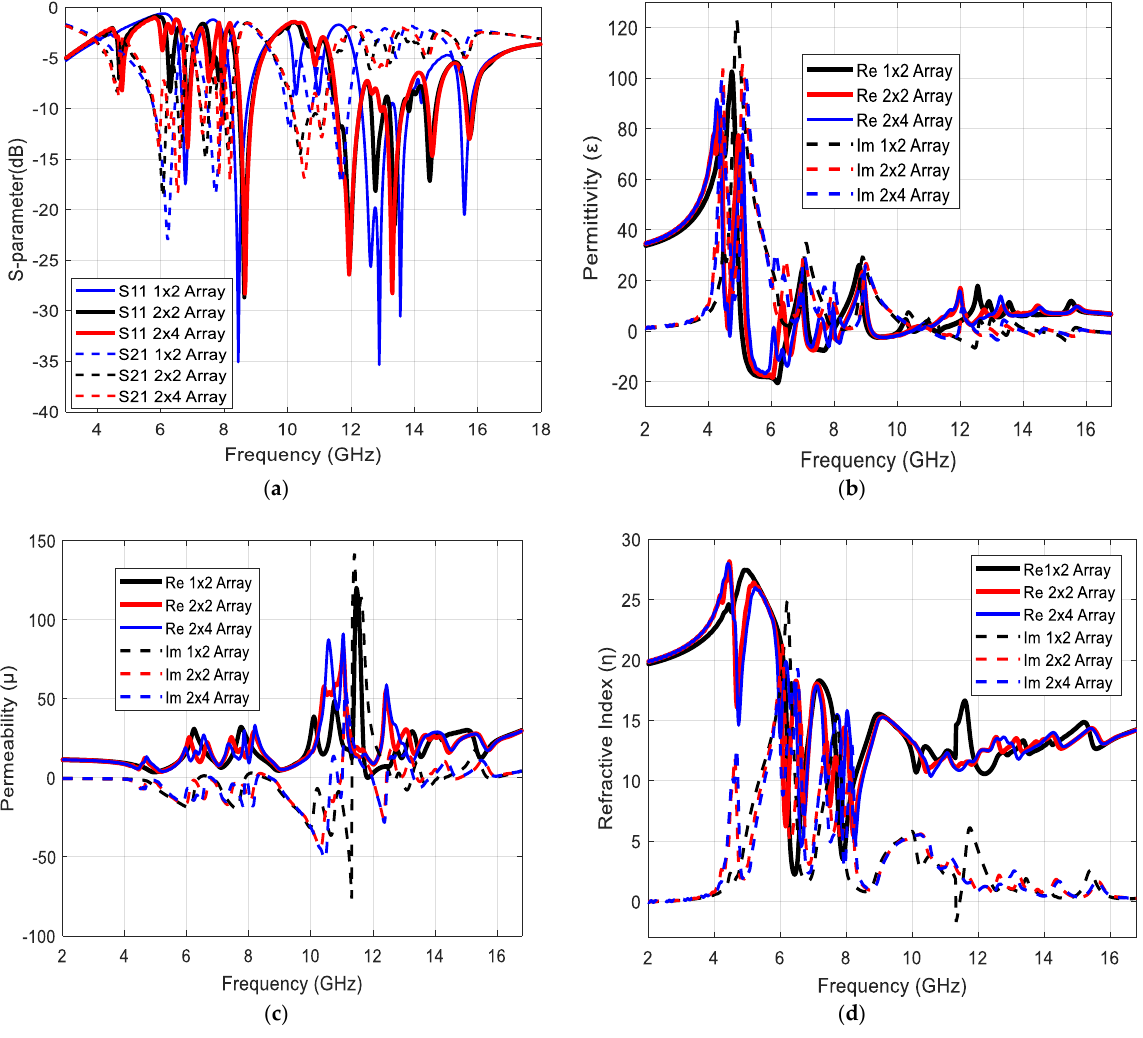
Figure 8. Parameters of array configurations: ( a ) S-parameters; ( b ) permittivity; ( c ) permeability; ( d ) refractive